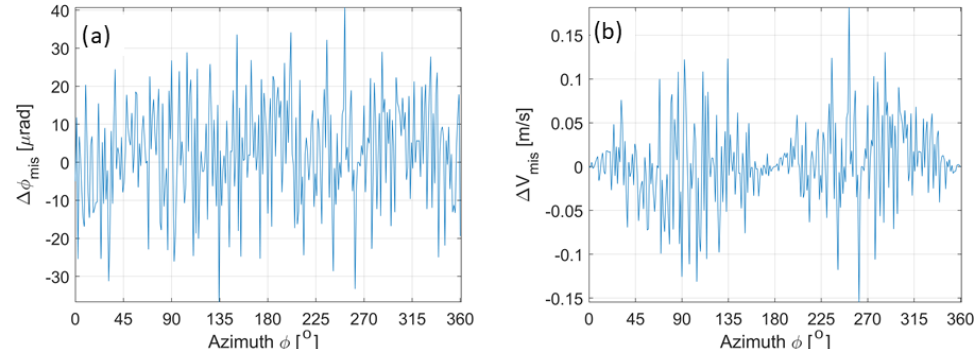
Figure 11. (a) One possible time series of the azimuthal scanning angle mispointing corresponding to a PSD, like in Fig. 10, as provided by preliminary industrial studies. (b) LOS velocity error corresponding to the mispointing shown in panel (a) . Mispointing errors corresponding to the PSD in Fig. 10 are generally smaller than 0.1ms − 1 , far lower than the precision of the Doppler velocity observations.